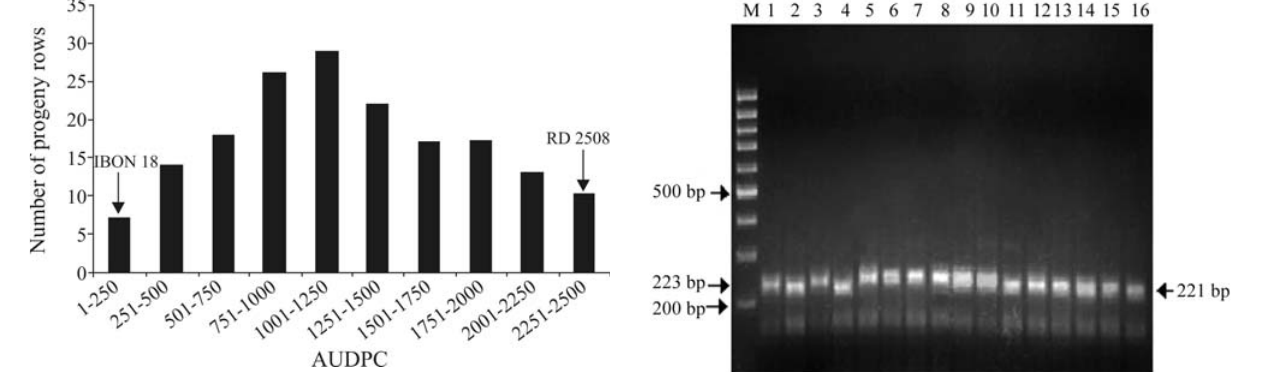
Figure4 -SelectivegenotypingofRILs(representingextremegroups)for spot blotch resistance in barley using BMS 90 SSRs primer; Lane M = 100-bp ladder marker; 1 = Resistant parent (IBON18); 2 = Suscepti- ble parent (RD2508); 3 = Resistant bulk; 4 = Susceptible bulk; 5-9 = RILs with low disease severity; 10-16 = RILs with high disease severity.